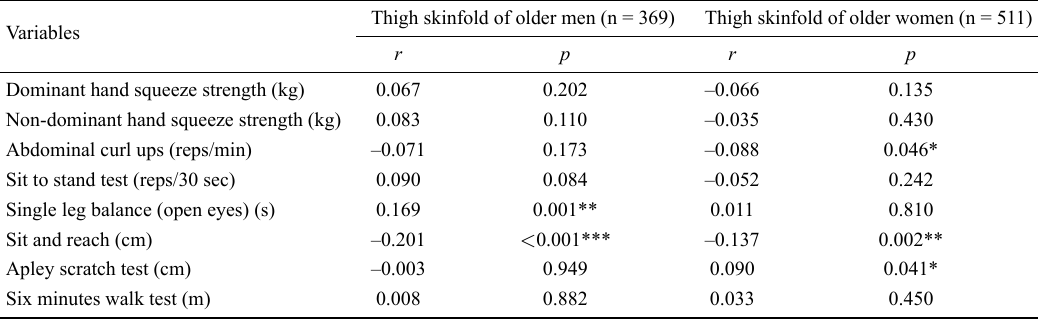
Table 5. Correlationships between thigh skinfold and physical fitness in the older (aged over 65